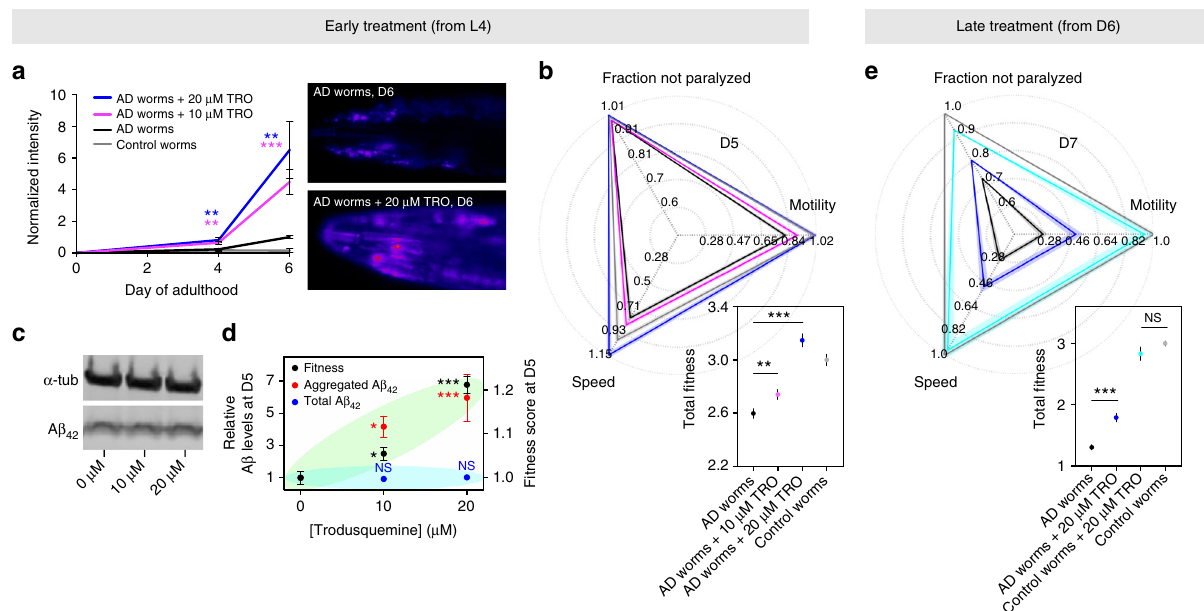
Fig. 5 Increased aggregation, but reduced toxicity in a C. elegans model of AD. a – d Worms were treated at the L4 stage of development. a NIAD-4 staining of AD worms incubated in the absence (black) or presence of 10 µ M (purple) and 20 µ M (blue) doses of trodusquemine. Representative images at D6 are shown. ** P < 0.01, *** P < 0.001 by Student ’ s t -test. Untreated control worms (grey) are shown for comparison. N = 20 per condition. b Motility, speed of swimming and the fraction of worms not paralyzed were monitored for AD worms incubated in the absence ( N = 342) or presence of 10 µ M ( N = 352) and 20 µ M ( N = 309) doses of trodusquemine. These parameters were summed to generate fi tness scores. ** P < 0.01, *** P < 0.001 by Student ’ s t -test. Untreated control worms ( N = 320) are shown for comparison. c Immunoblot measurements of the total A β levels in AD worms after treatment. Data shown are representative of duplicate blotting procedures. d Correlation between the concentration of trodusquemine administered and the increase in AD worm fi tness (black, from b , * P < 0.05, *** P < 0.001 by one-way ANOVA), the relative quantity of aggregated A β 42 (red, averages of D4 and D6 from a , * P < 0.05, *** P < 0.001 by one-way ANOVA) and the total levels of A β 42 (blue, Supplementary Figure 13, NS: not signi fi cant by one-way ANOVA). All one- way ANOVA were followed by Bonferroni ’ s multiple comparison test relative to untreated AD worms. Panels b – d represent D5 of adulthood. e AD worms were also treated at D6 with ( N = 88) and without 20 µ M TRO ( N = 105) and monitored at D7 for the conditions described in b . Fitness scores were calculated as above. *** P < 0.001 by Student ’ s t -test. Untreated ( N = 434) and treated ( N = 84) control worms (cyan) are shown for comparison. NS: